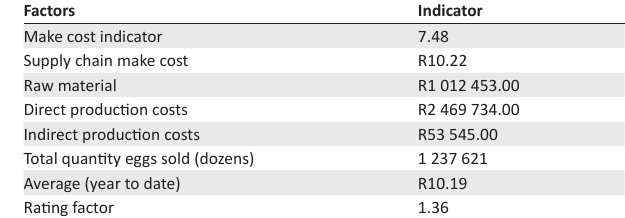
TABLE 23: Make cost.